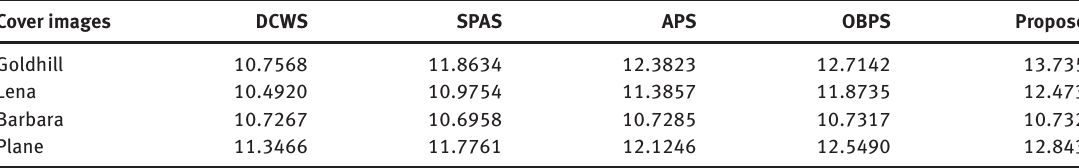
Table 4: PSNR Values of Extracted